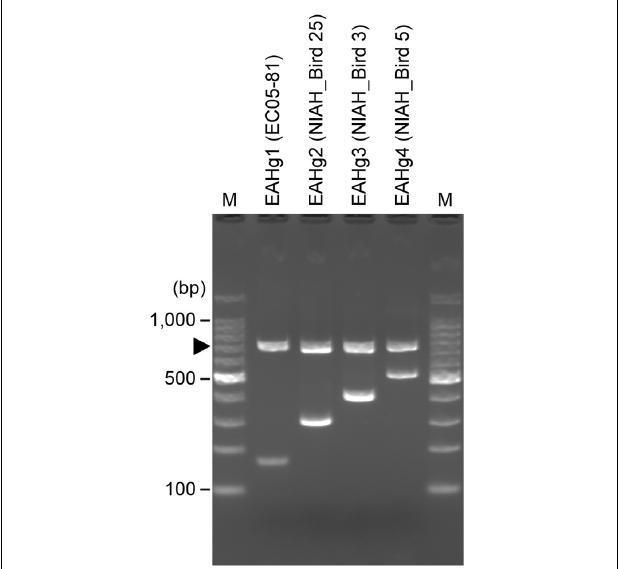
FIGURE 2 | Electrophoresis patterns obtained by EAH-genotyping PCR. A total of four strains representing the four EAHgs were analyzed using a PCR primer mix designed in this study. Strain names are indicated in parentheses. An arrowhead indicates the bands derived from the E. albertii -specific primer pair E_al_1_NF/NR. Lane M, 100 bp DNA